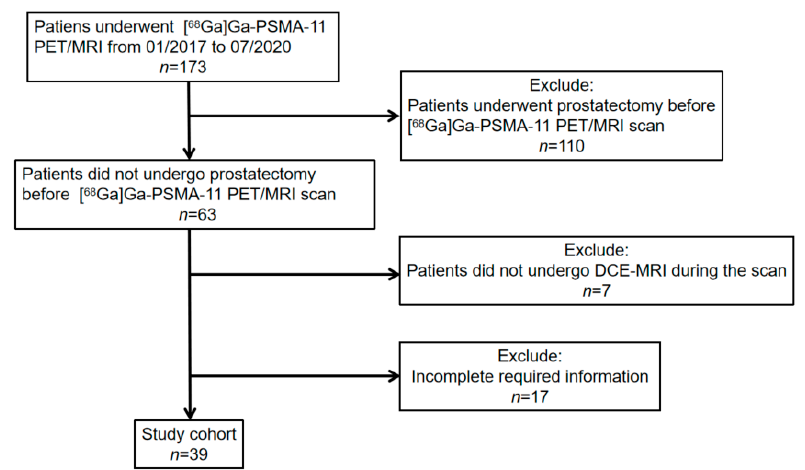
Figure 4. [ 68 Ga]Ga-PSMA-11 PET: gallium 68-labeled prostate-specific membrane antigen PET, DCE-MRI: Dynamic contrast-enhanced magnetic resonance imaging.